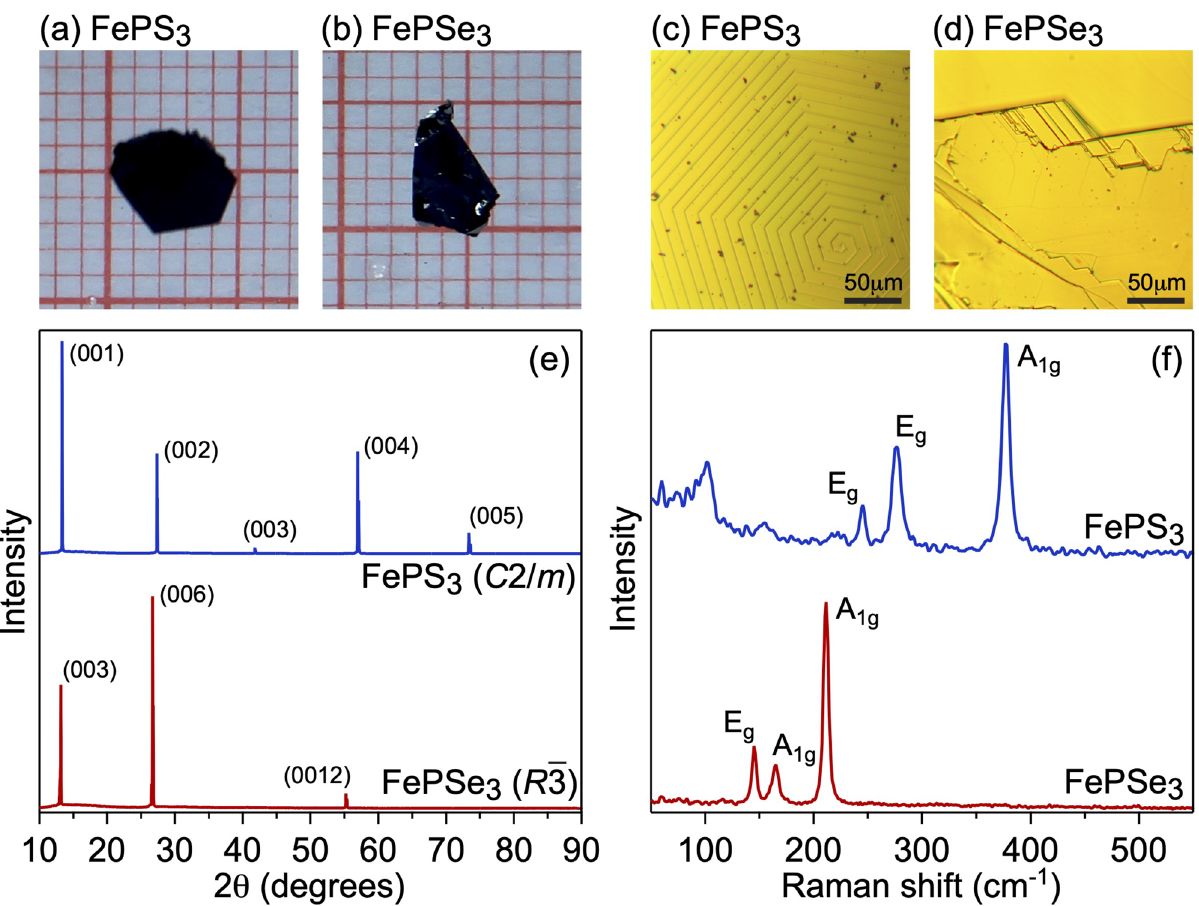
Figure 2. Characterization of FePX 3 crystals: ( a , b ) photos, ( c , d ) optical microscopy images, ( e ) XRD patterns and ( f ) Raman spectra measured at room temperature for bulk samples. Images are created using Igor Pro (Version 9), https:// www. wavem etrics.